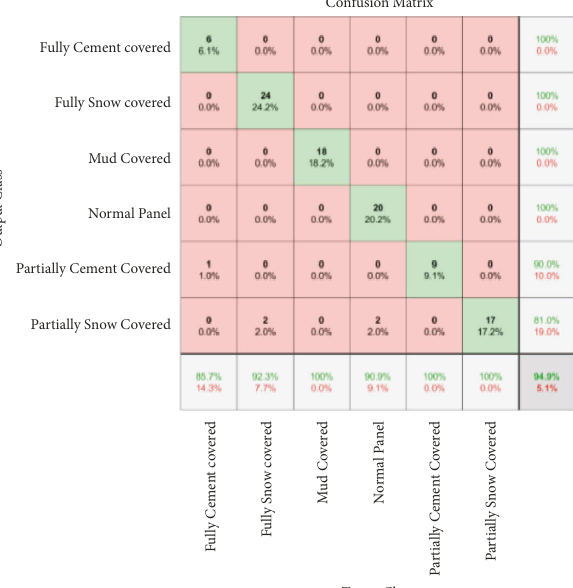
Figure 11: Confusion matrix for